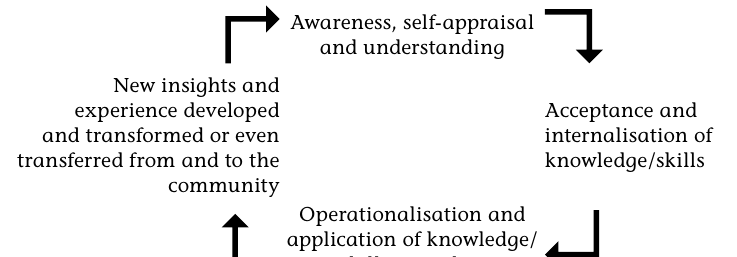
Figure 1: Cycle of reflective